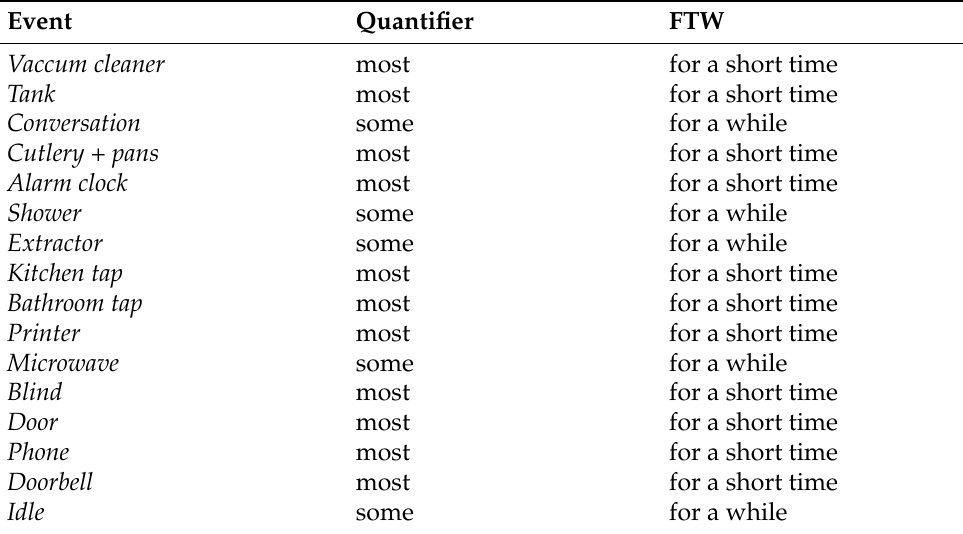
Table 7. Quantifiers and FTWs which define the protoforms corresponding to temporal restrictions for audio